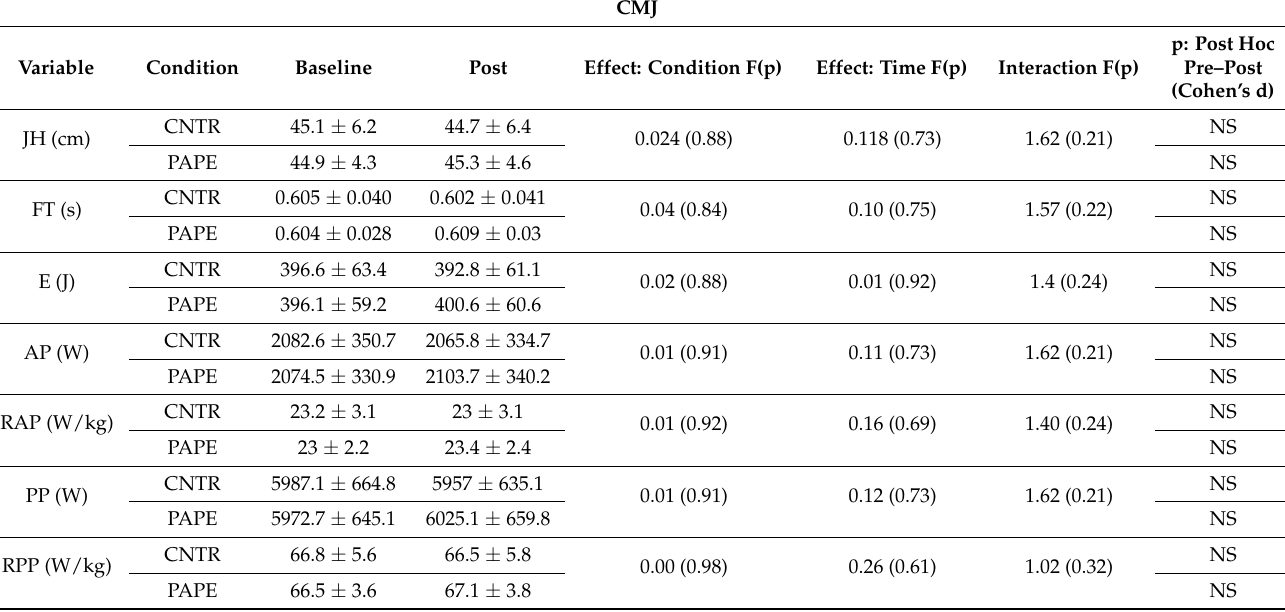
Table 1. Results of jumping tests for all participants at the baseline and after CA (presented as mean ±